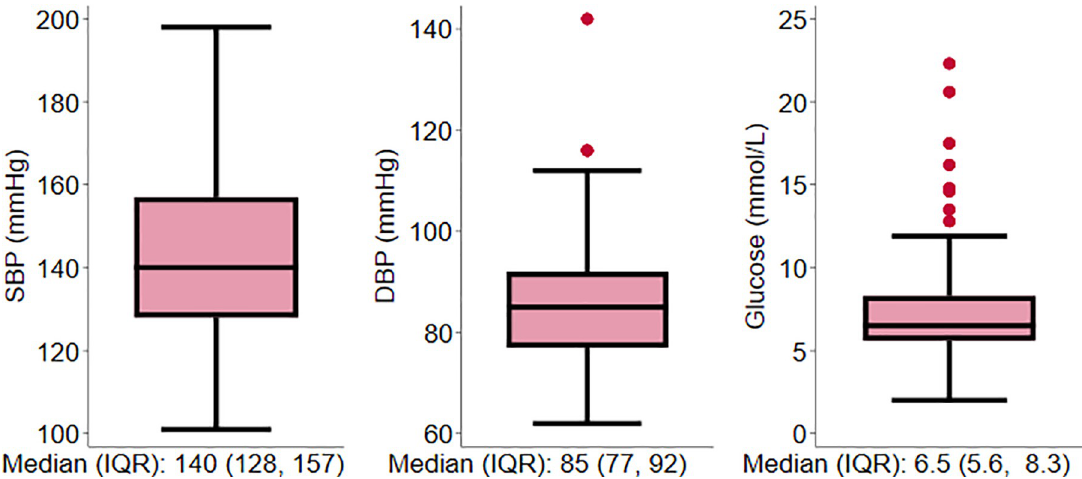
Fig 1. Systolic blood pressure, diastolic blood pressure, and blood glucose levels among study participants.